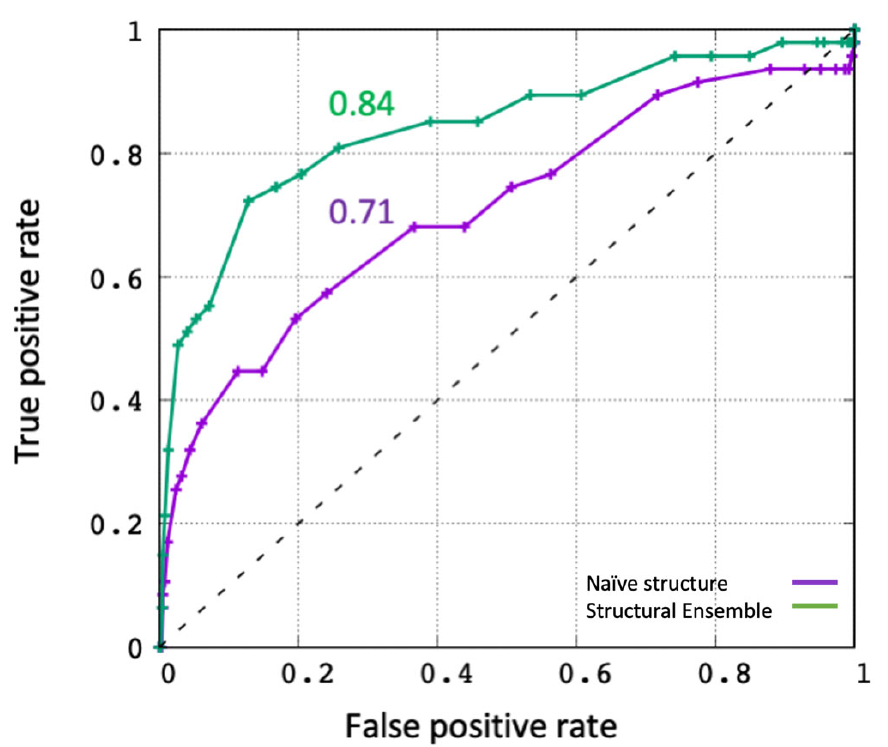
Figure 4. Receiver operating curves (ROC) to evaluate performance of the in silico screening. Docking of active (47) and decoy (1652) molecules was performed against the crystal structure of Trypsin (purple) and against the structural ensemble generated by REMD simulations (green). The area under the curve (AUC) values are also shown.